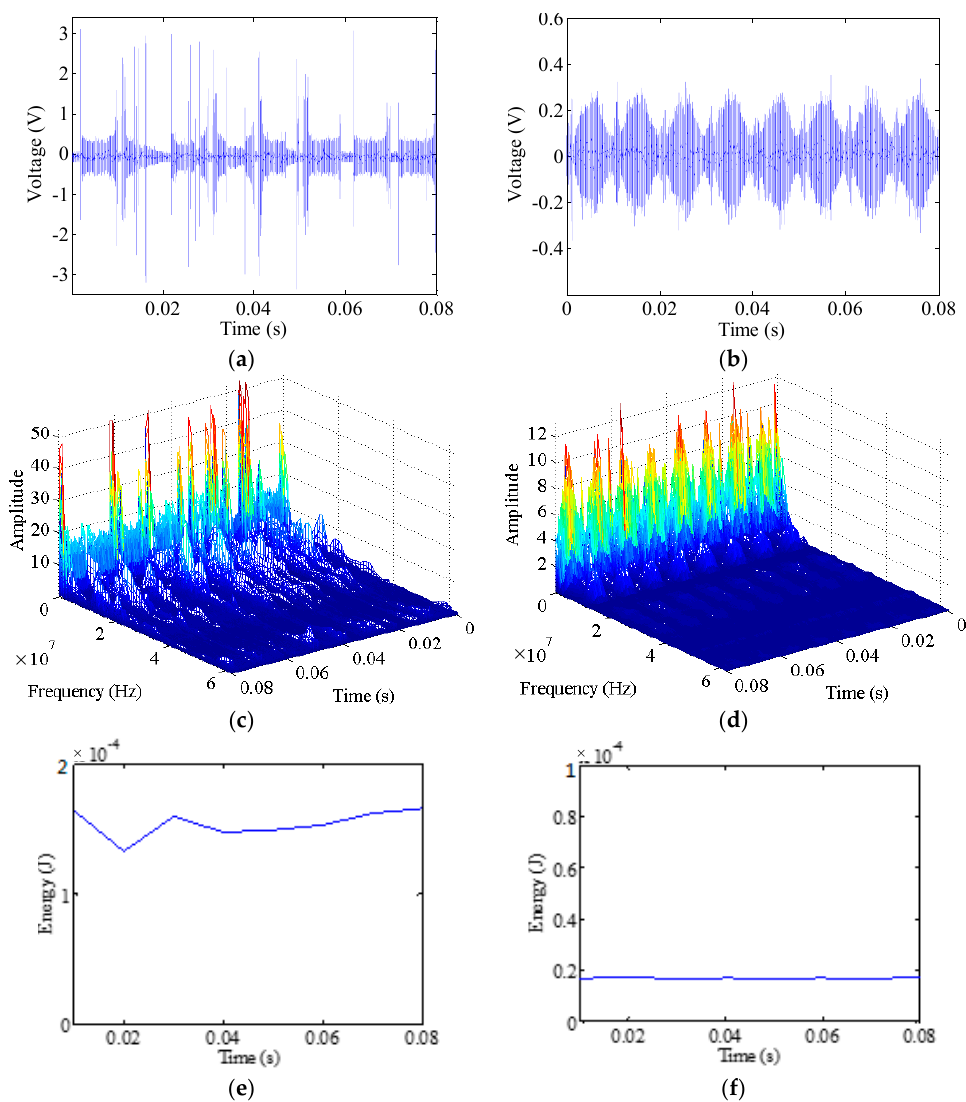
Figure 9. Signal analysis of halogen lamps: ( a ) high-frequency signals of arc faults; ( b ) high-frequency signals under normal operation; ( c ) signals’ STFT of arc fault signals; ( d ) signals’ STFT under normal operation; ( e ) high-frequency energy of arc faults; ( f ) high-frequency energy under normal operation.